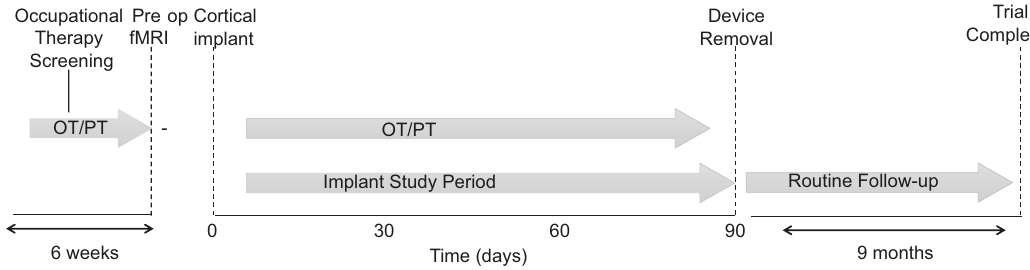
Fig. 1 The clinical trial timeline. This fi gure shows the sequence of the Cortimo clinical